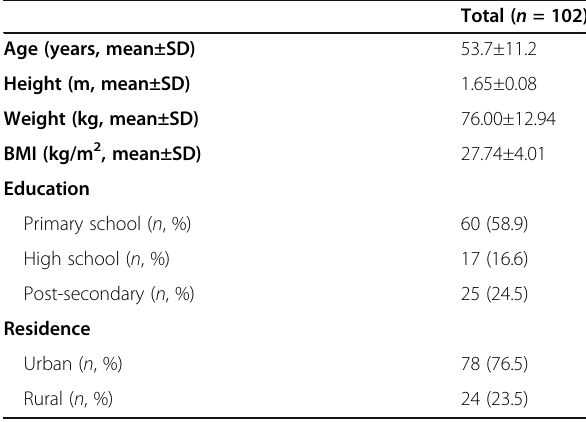
Table 1 Socio-demographic information and characteristics of the patients